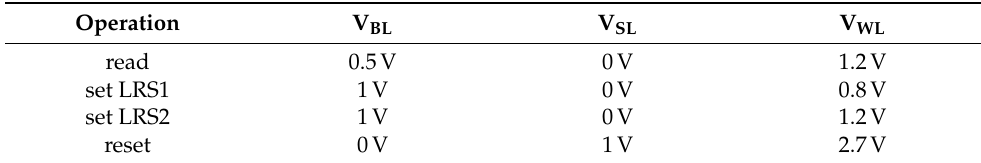
Figure 2. Block diagram of the memory block. The digital inputs are marked in red, the outputs in green and the internal analog signals in blue. A logic block sets several control signals for the operational amplifier (opamp), the memory cells, and the reference block. The power supply control connects or disconnects the whole memory block from the supply rails according to the power enable signal pwr_en . Table 1. Voltage levels for cell